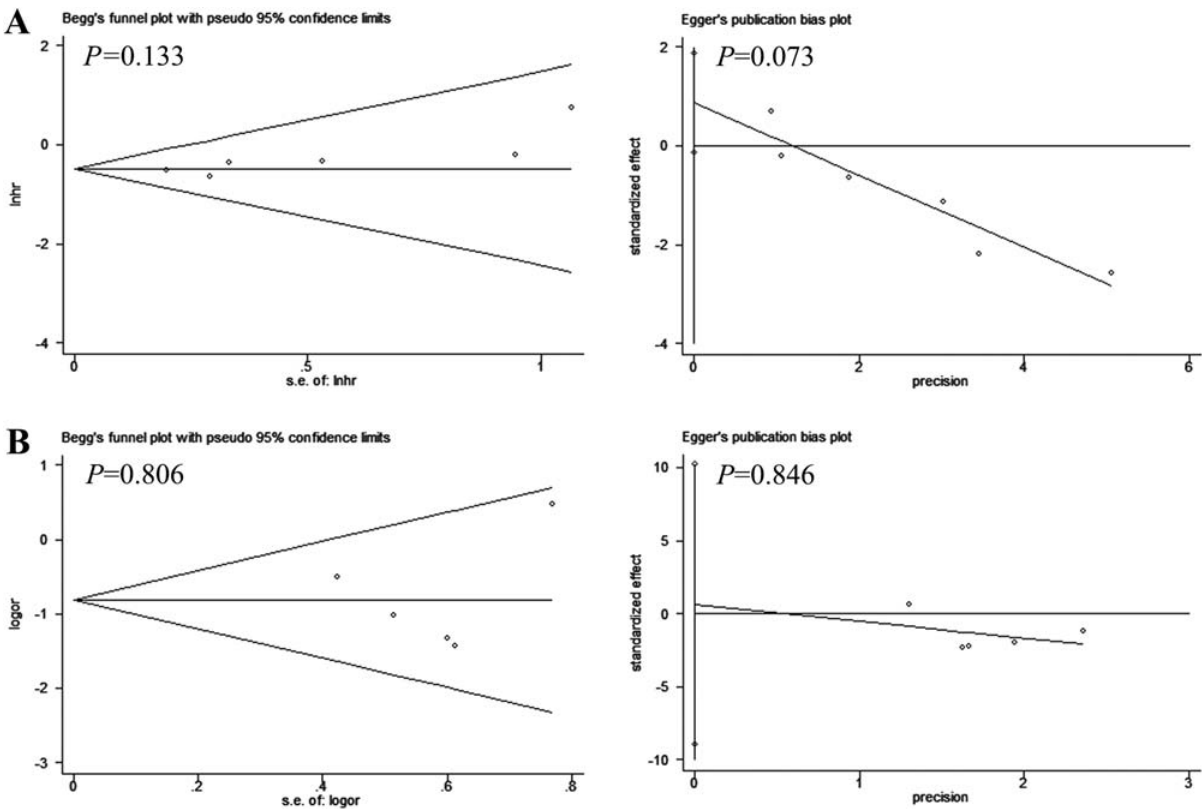
Figure 5: Begg ’ s funnel plot and Egger ’ s test for publication bias. ( A ) Overall survival and ( B ) TNM